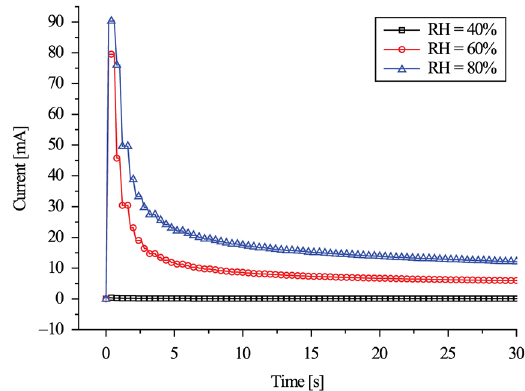
Figure 3. Electromechanical response of N117 based IPMC with Na + conditioned in an environment kept in RH=80%.